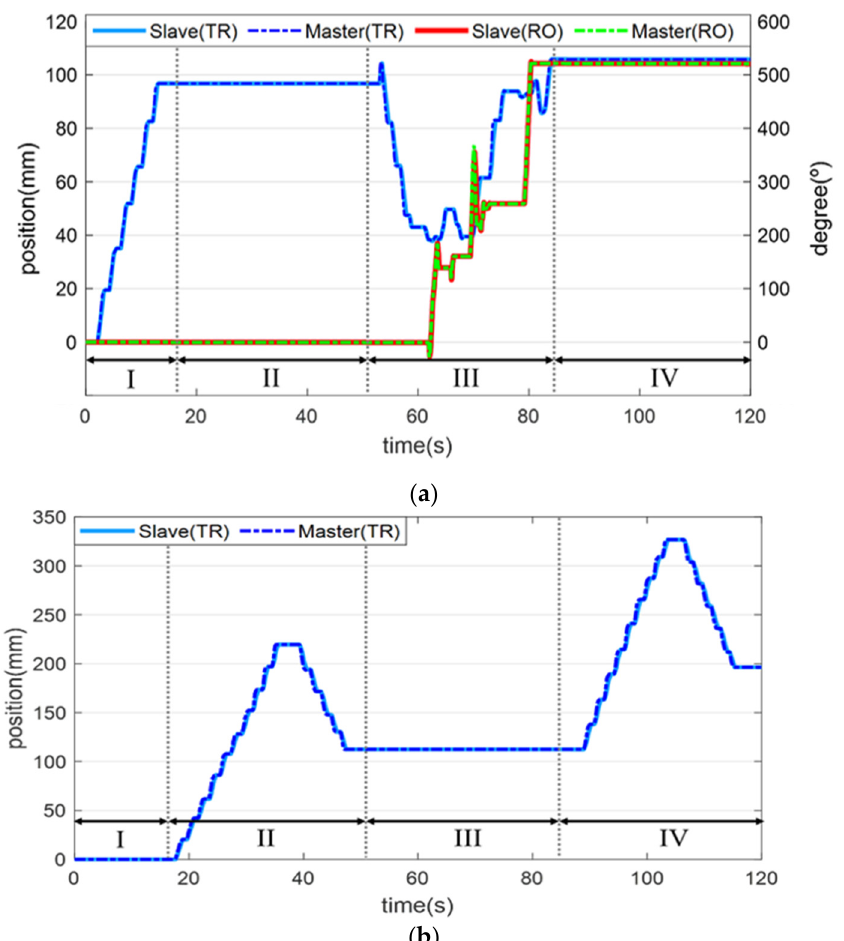
Figure 14. Translation and rotation information of the ( a ) guidewire and ( b ) balloon catheter when they are navigated to the target points.